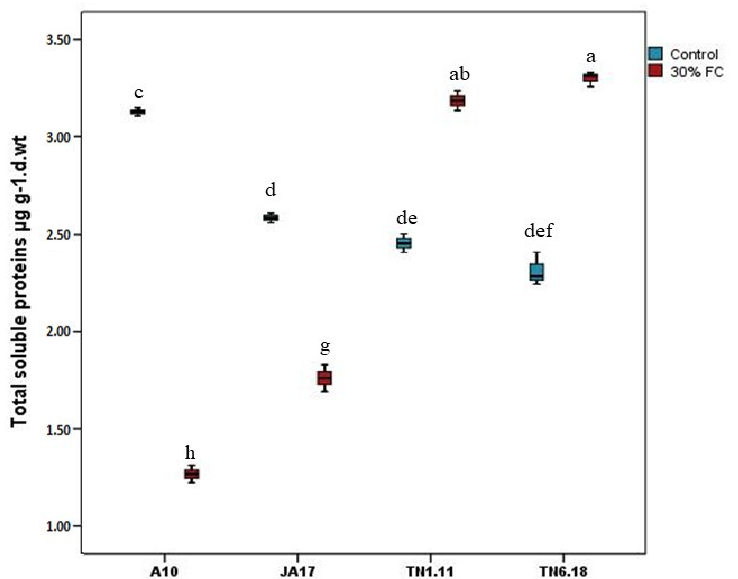
Figure 8. Variation of total protein content in M. truncatula studied lines under control treatment and 30% FC. Means followed by the same or a common letter (s) are not significantly different among the studied lines for each trait according to Duncan’s test at